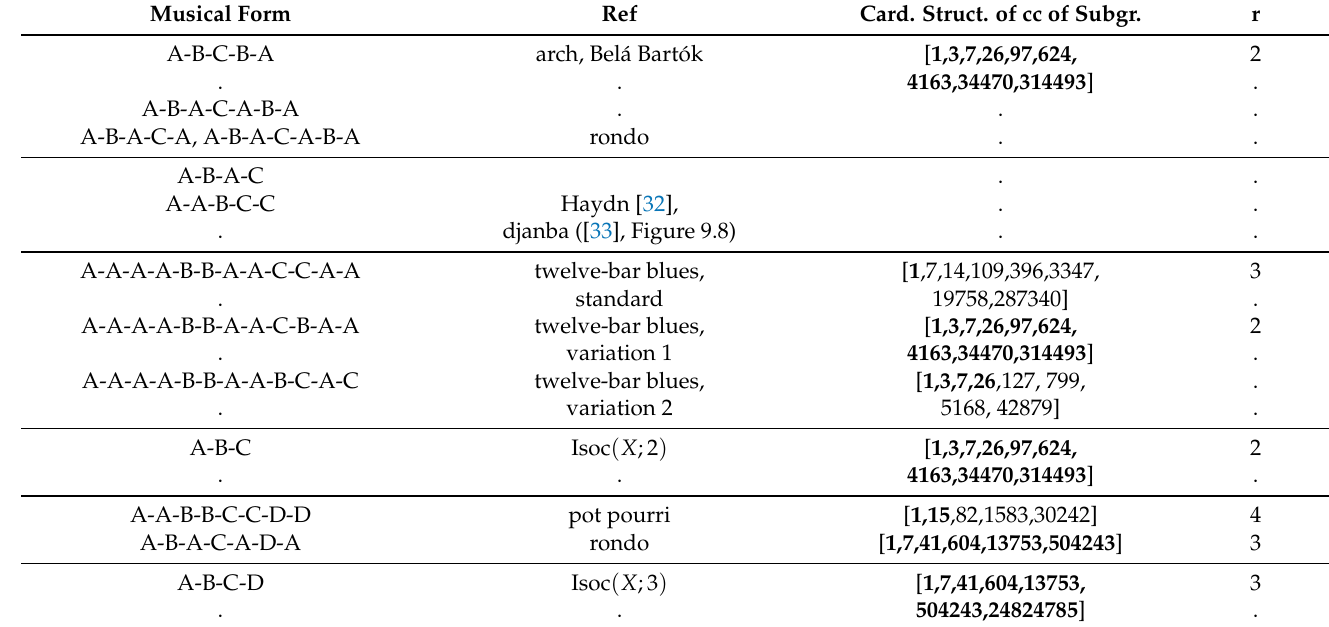
Table 4. Group analysis of a few musical forms whose structure of subgroups, apart from exceptions, is close to Isoc ( X ; d ) with d = 2 (at the upper part of the table) or d = 3 (at the lower part of the table). Of course, the forms A-B-C and A-B-C-D have the cardinality sequence of cc of subgroups exactly equal to Isoc ( X ;2 ) and Isoc ( X ;3 ) , respectively. Musical Form Ref Card. Struct. of cc of